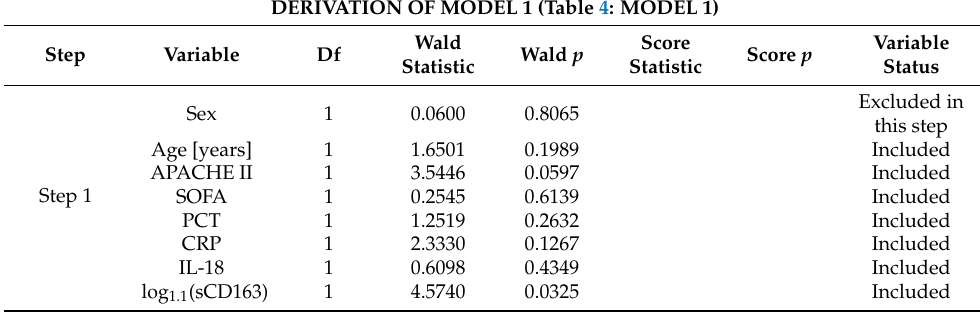
Table A3. Iterative process of variable exclusion used in determining the logistic regression model featured in this